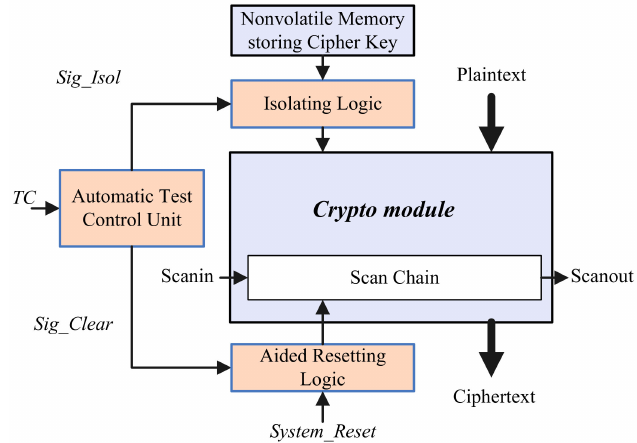
Figure 2. Hardware framework of proposed secure scan test scheme.